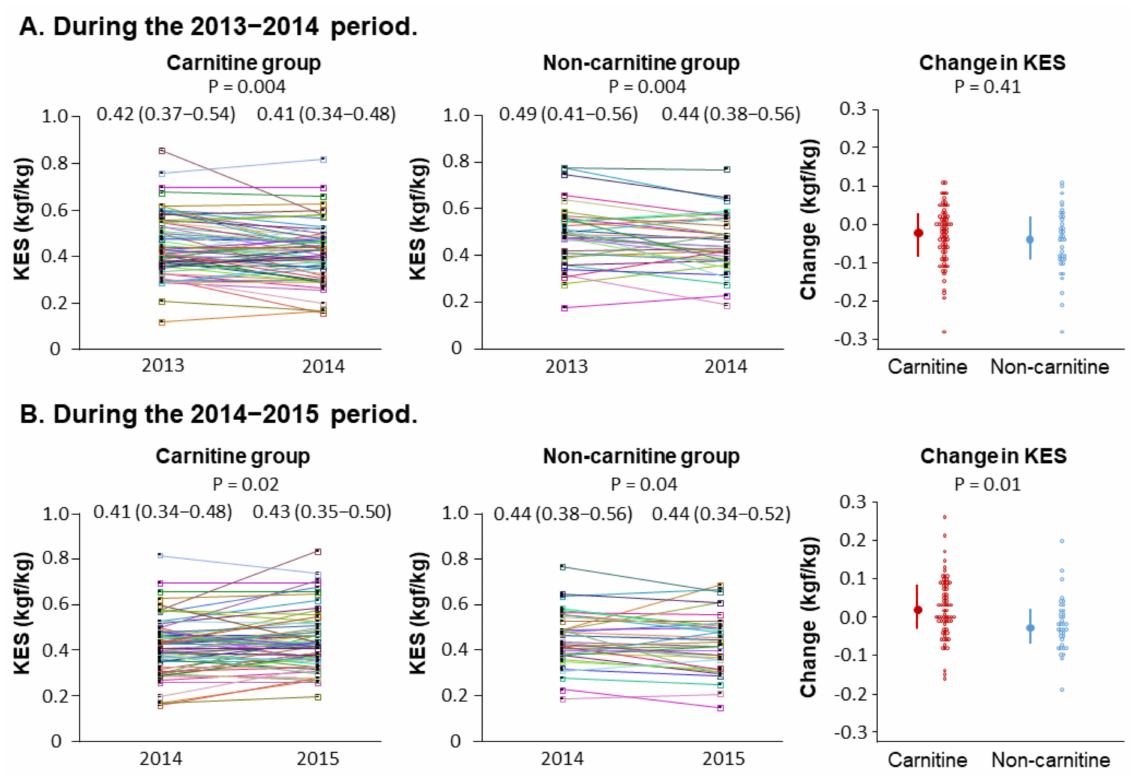
Figure 2. Changes in knee extensor strength. The graphs show individual measurements of knee extensor strength in the carnitine and non-carnitine groups and the between-group comparison of the one-year changes during the 2013–2014 period ( A ) and during the 2014–2015 period ( B ). In the carnitine group, treatment with levocarnitine was done only in the period from 2014 and 2015. The error bars represent interquartile ranges. Abbreviation: KES, knee extensor